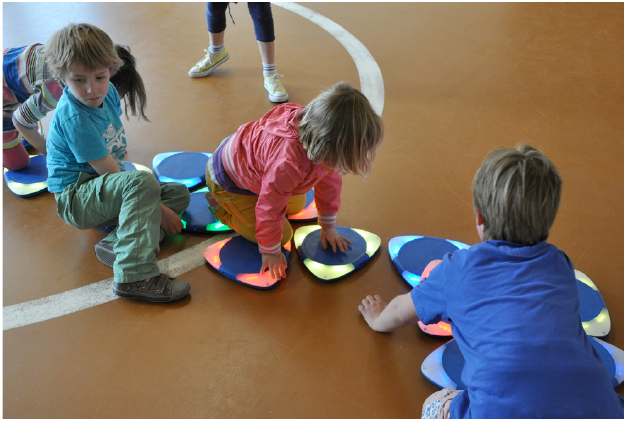
Figure 1. Children playing with